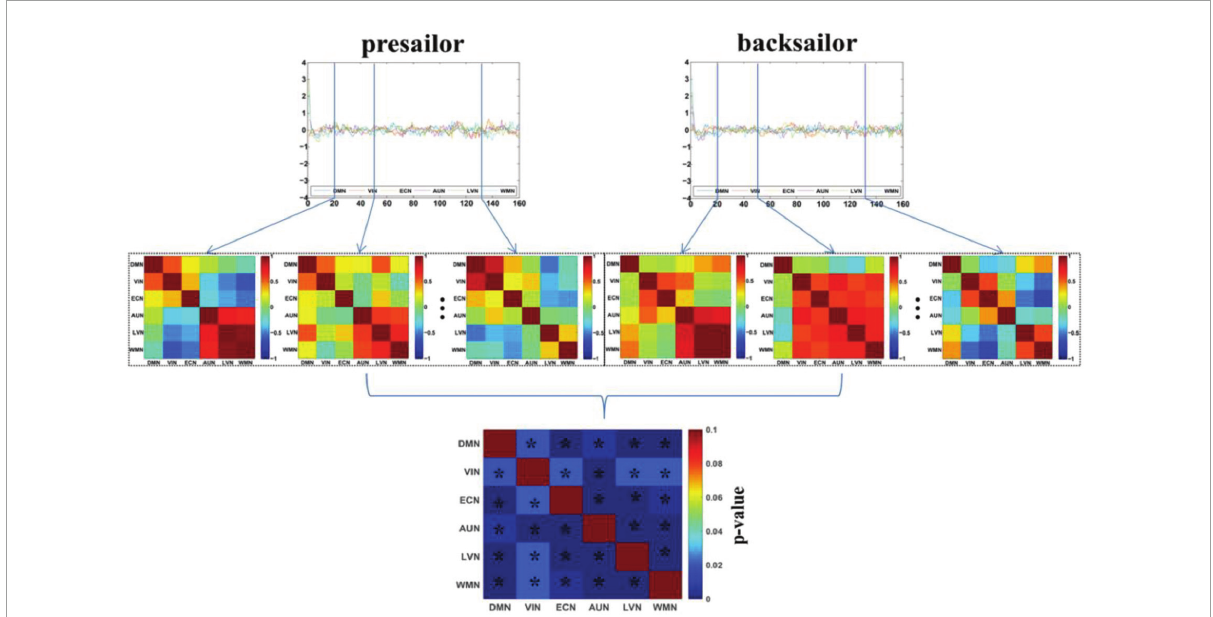
FIGURE2 The DFC networks among the six resting-state brain networks of seafarers before and after sailing at the group level, as well as the statistical test results of differences between them. The asterisk indicates that there is a significant difference with a confidence level of p < 0.05.